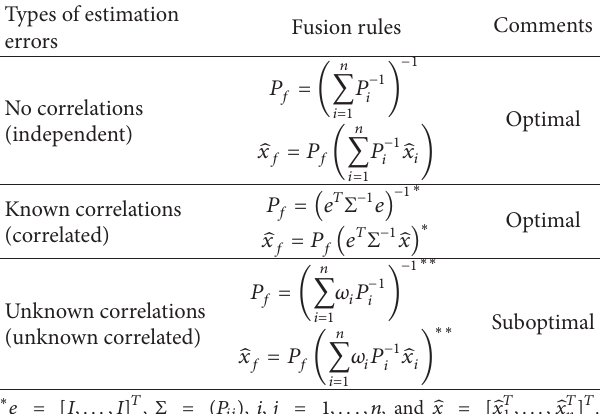
Table 1: Multisensor fusion